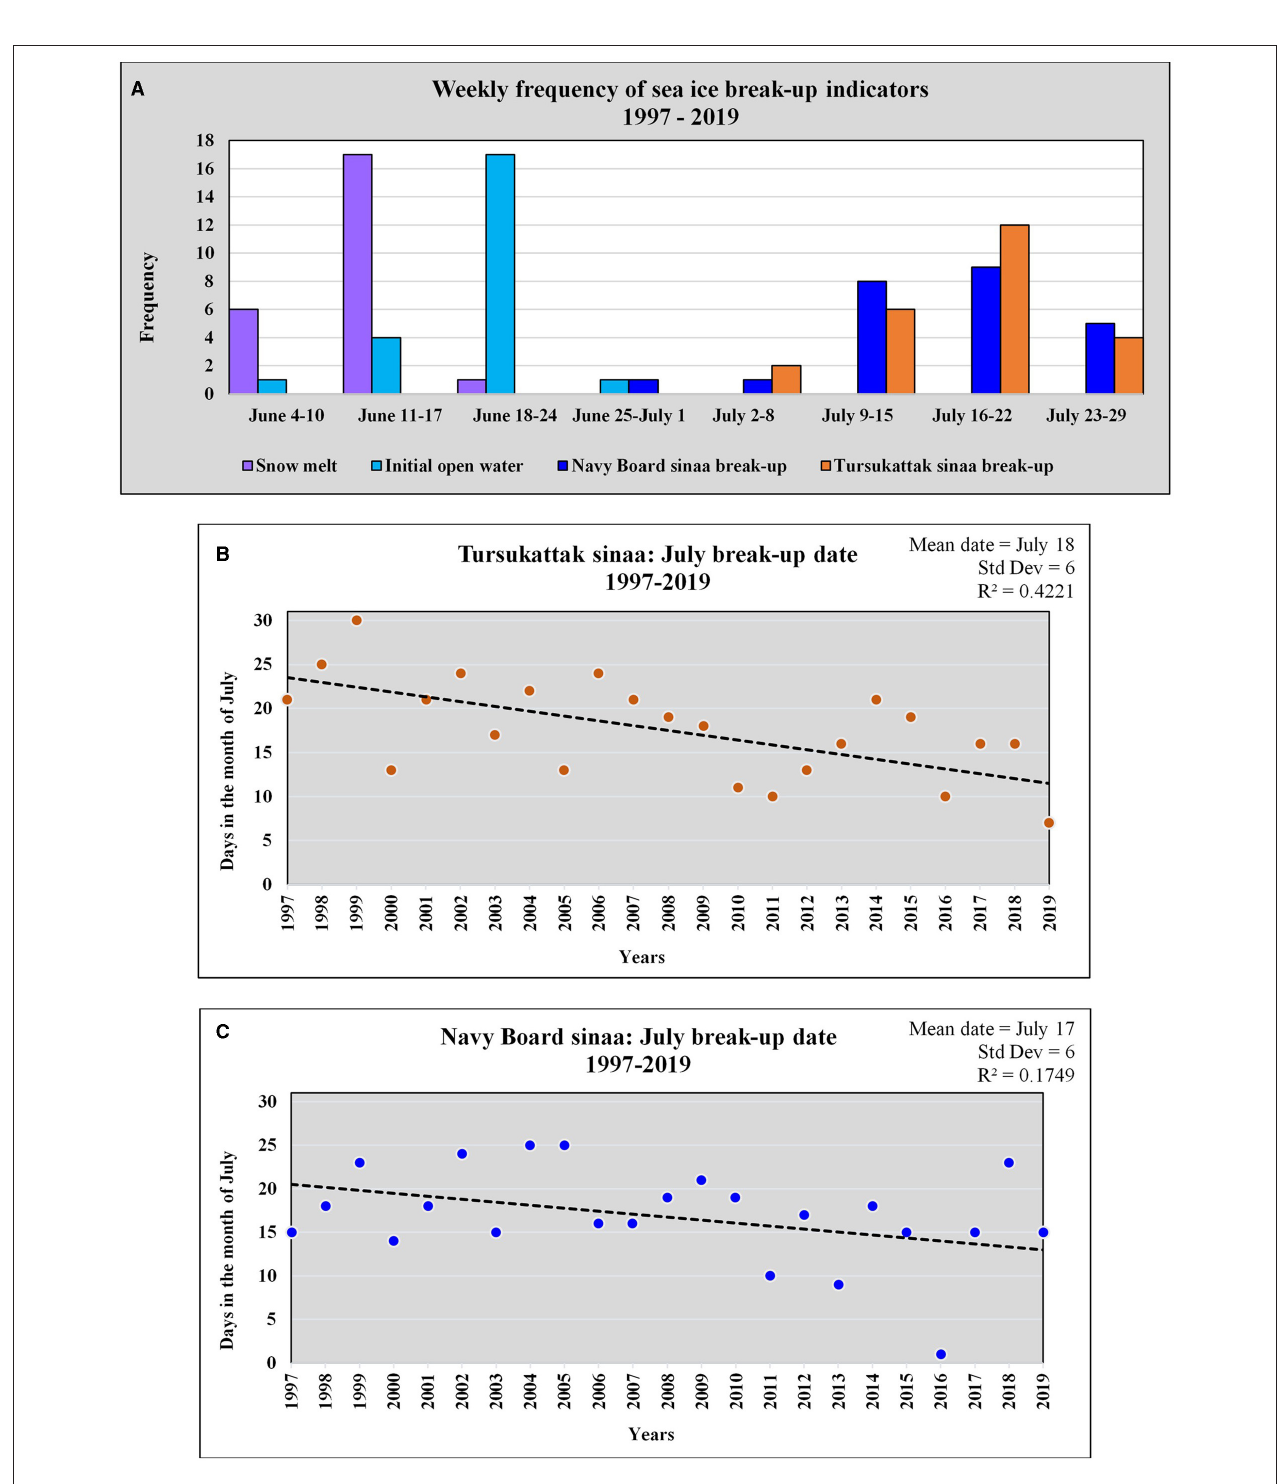
FIGURE 10 | (A) Frequency graph for indicators of break-up, 1997–2019. (B) Graph showing the Tursukattak sinaa July break-up dates, 1997–2019. (C) Graph showing the Navy Board sinaa July break-up dates, 1997–2019.